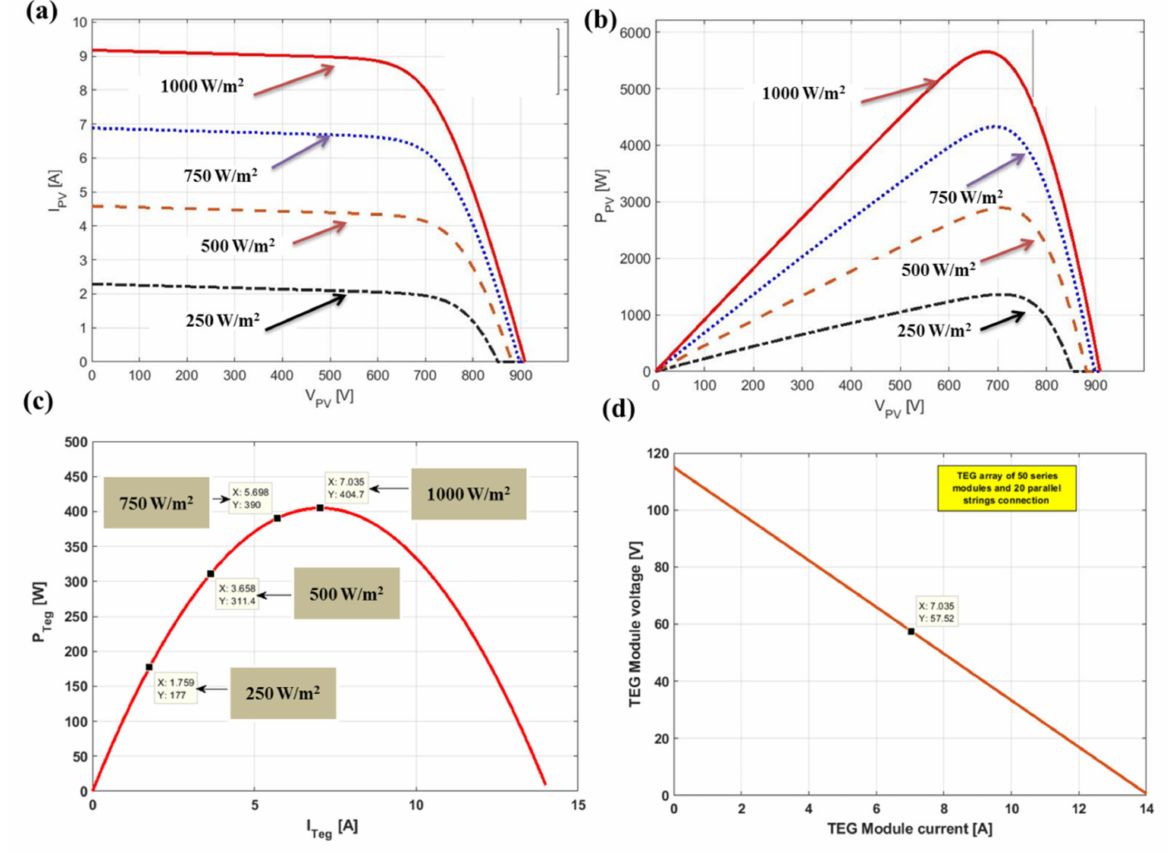
Figure 6. ( a ) The perovskite solar cell array relationships between current and voltage as irradiation levels change. ( b ) The perovskite solar cell array relationships between power and voltage as irradiation levels change. ( c ) The TEG (TE-MOD-1W2V-40S) power–voltage curve. ( d ) The TEG (TE-MOD-1W2V-40S) current–voltage